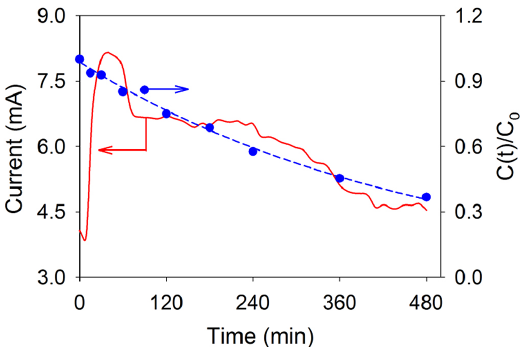
Figure 9. Copper concentration and measured current for 8 hours of reaction. The photo‑assisted electrolysis was carried out with a 1 layered PEG modified TiO photo‑anode. 2